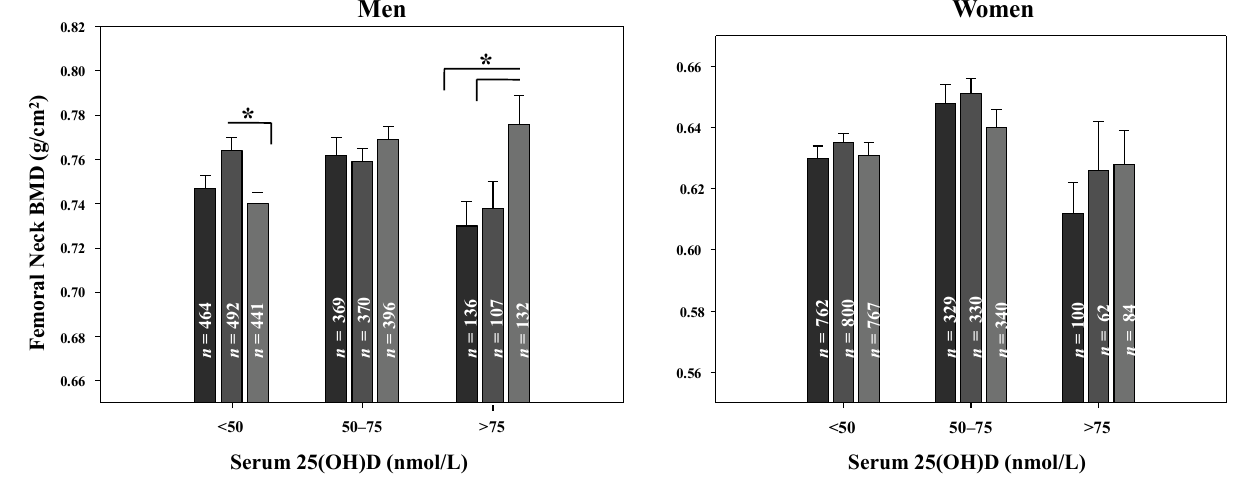
Figure 2. The bone mineral density of total hip and femur neck by serum 25-hydroxyvitamin D concentration and dietary vitamin A intake. Three bars represent tertiles of vitamin A intakes (A1, mean 217.8; A2, mean 577.4; A3, mean 1353.4 μg RE) for men and (A1, mean 156.4; A2, mean 449.6; A3, mean 1163.6 μg RE) for women. BMD, bone mineral